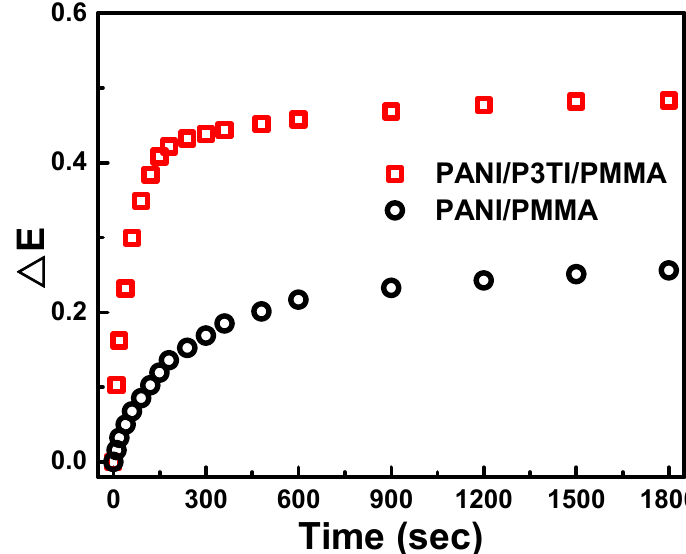
Figure 6. Extinction change of PANI / PMMA and PANI / P3TI / PMMA fibers when exposed to 2000 ppm n-butanol.